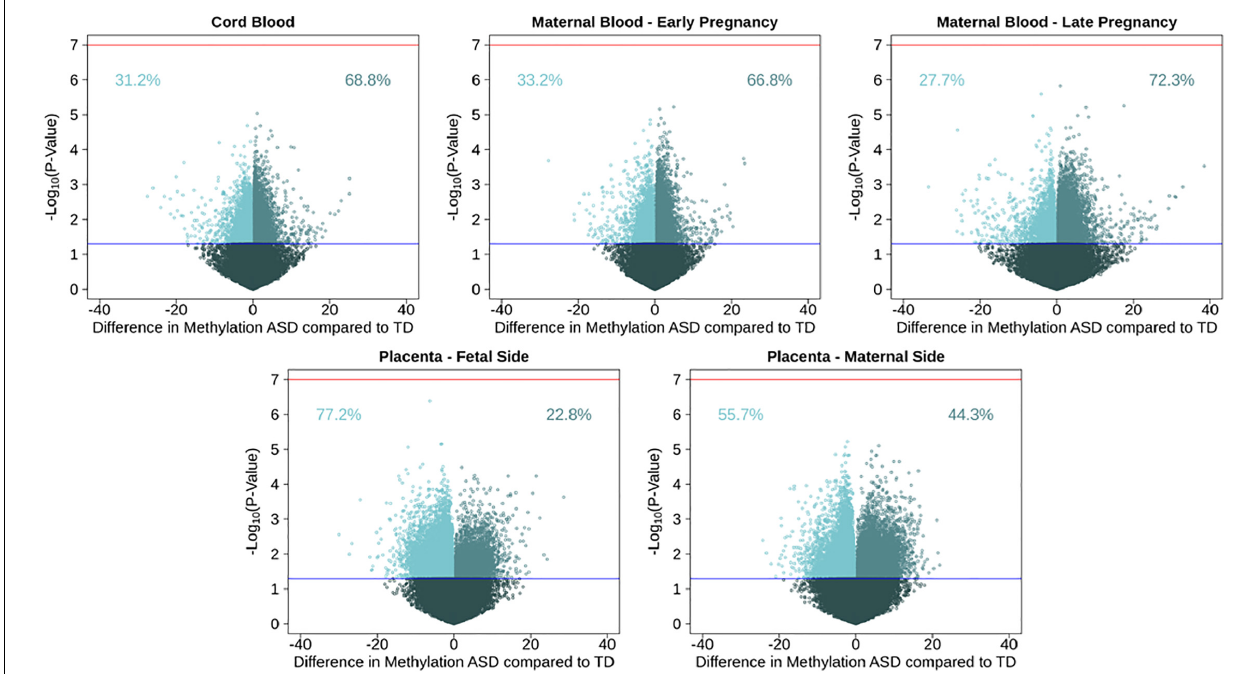
FIGURE 1 | Volcano plots for single CpG site associations comparing ASD cases to a typical development reference group, showing percent methylation and –log 10 ( P -values). Models were run in five tissues: maternal blood in early and late pregnancy, cord blood, and placental tissue on the fetal and maternal sides. Red line represents genome wide significance level of 10 − 7 , and blue line represents nominal p -value of 0.05. Percentages show proportion of nominally significant CpG sites with positive or negative effect